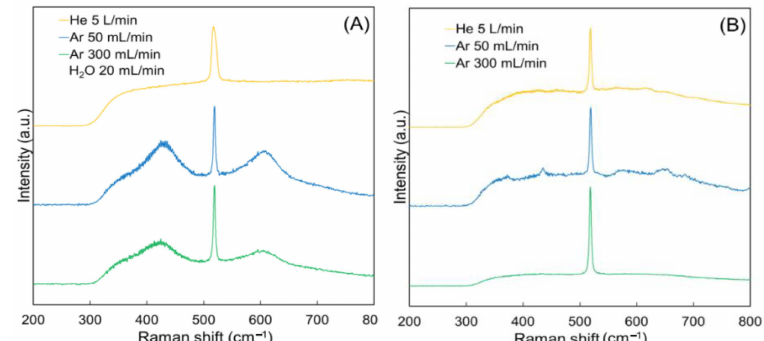
Figure 2. ( A ) Raman spectra of TiO 2 thin films with H 2 O flow rate 20 mL/min, ( B ) without H 2 O flow rate.